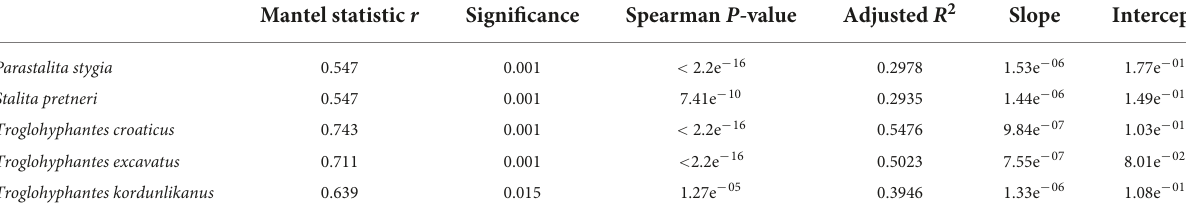
TABLE 3 Correlations among pairwise genetic and geographic distances based on Mantel tests and Spearman’s rho correlation coefficient. Adjusted R -squared ( R 2 ) of the linear model are included and linear equations are indicated in slope-intercept form. Mantel statistic r